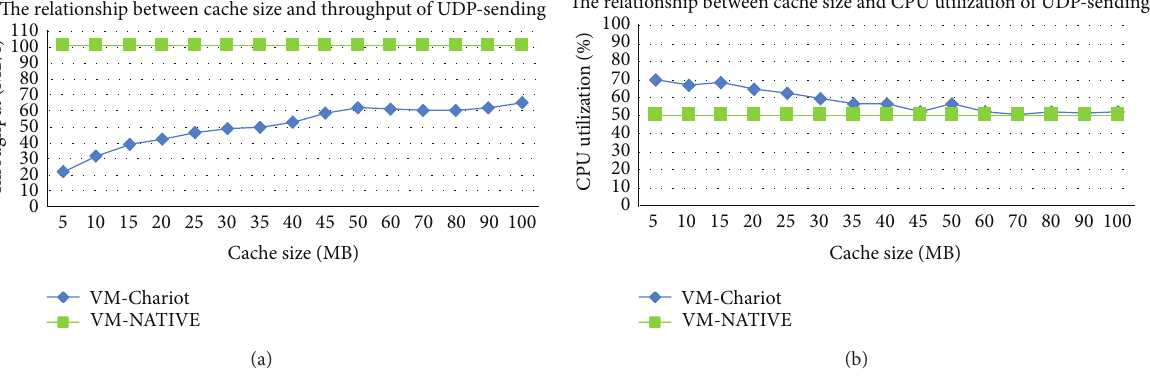
Figure 6: The sending performance of UDP benchmark impacted by different cache sizes.